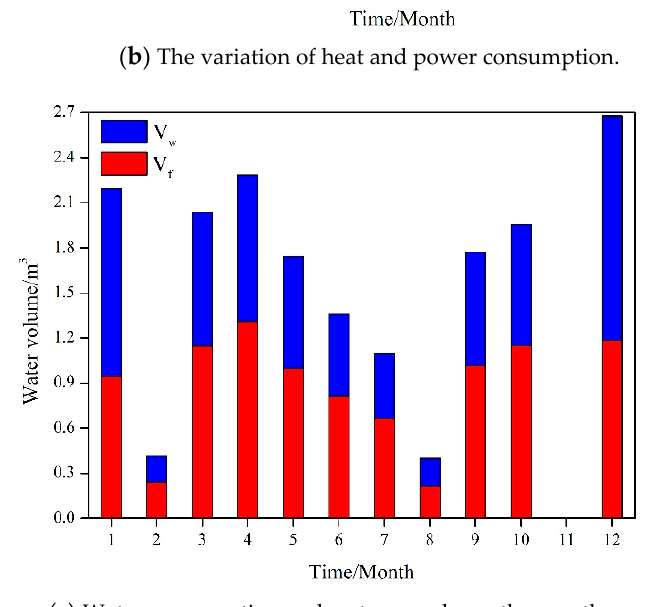
Figure 5. Average index in a day that varies every month. Table 1 shows the annual performance of the solar hot-water system. In a typical day, the weather with high irradiance was analyzed. The solar heat-cycle system ran from 8:00 to 16:00, but was not run continuously or full time. Table 1 shows the average daily set thermal efficiency could reach 56.63%. Table 1. Annual operating parameters. Date